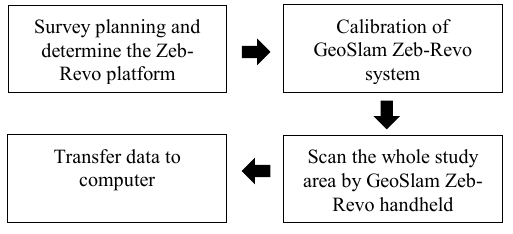
Figure 7. GeoSlam Zeb-Revo method